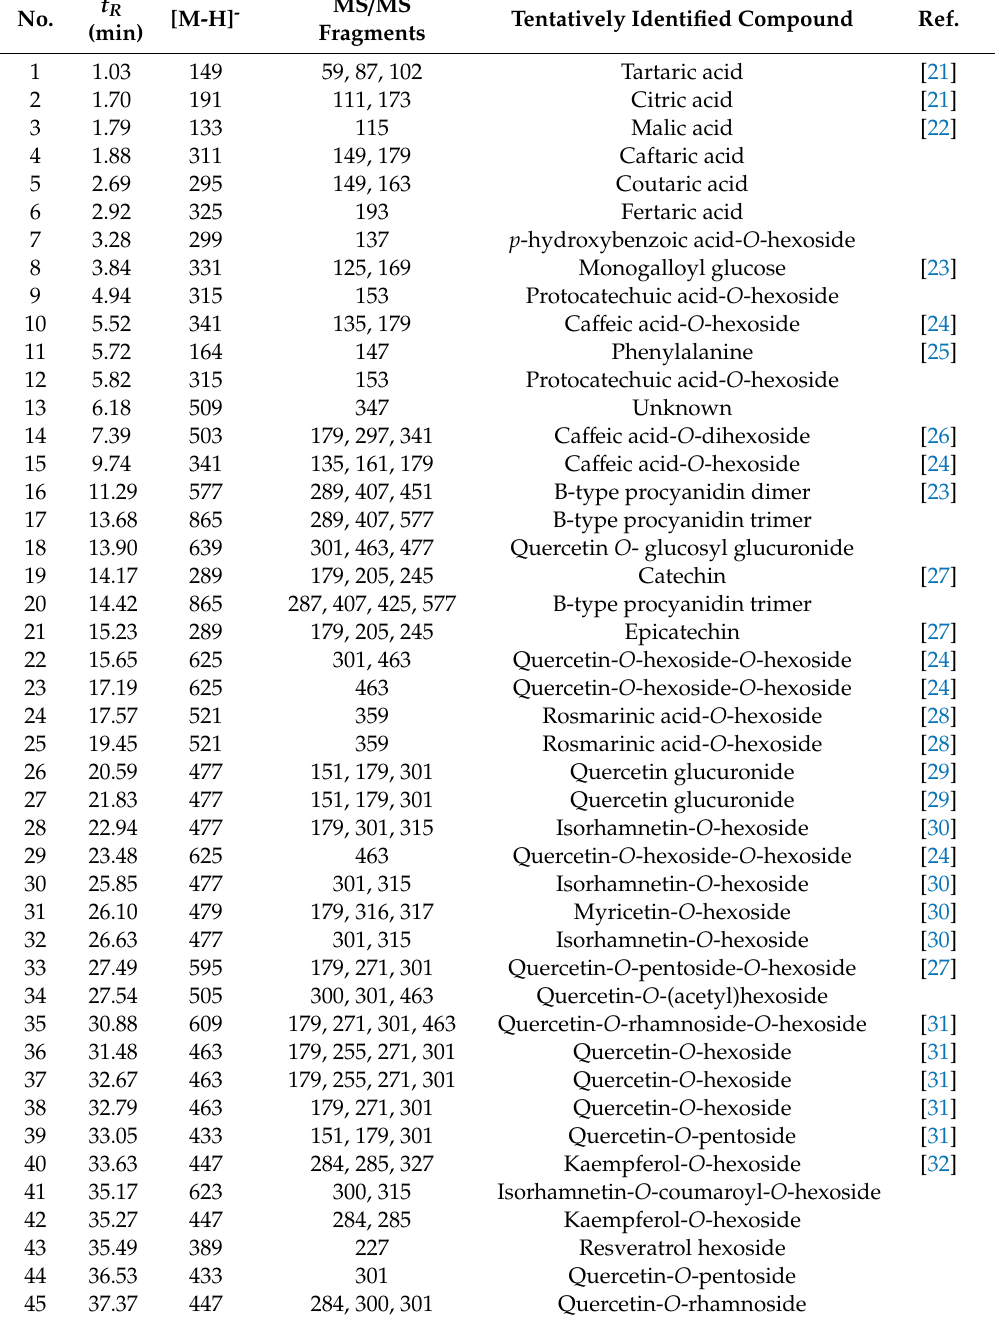
Table 2. Chemical composition of methanol extract of grapes